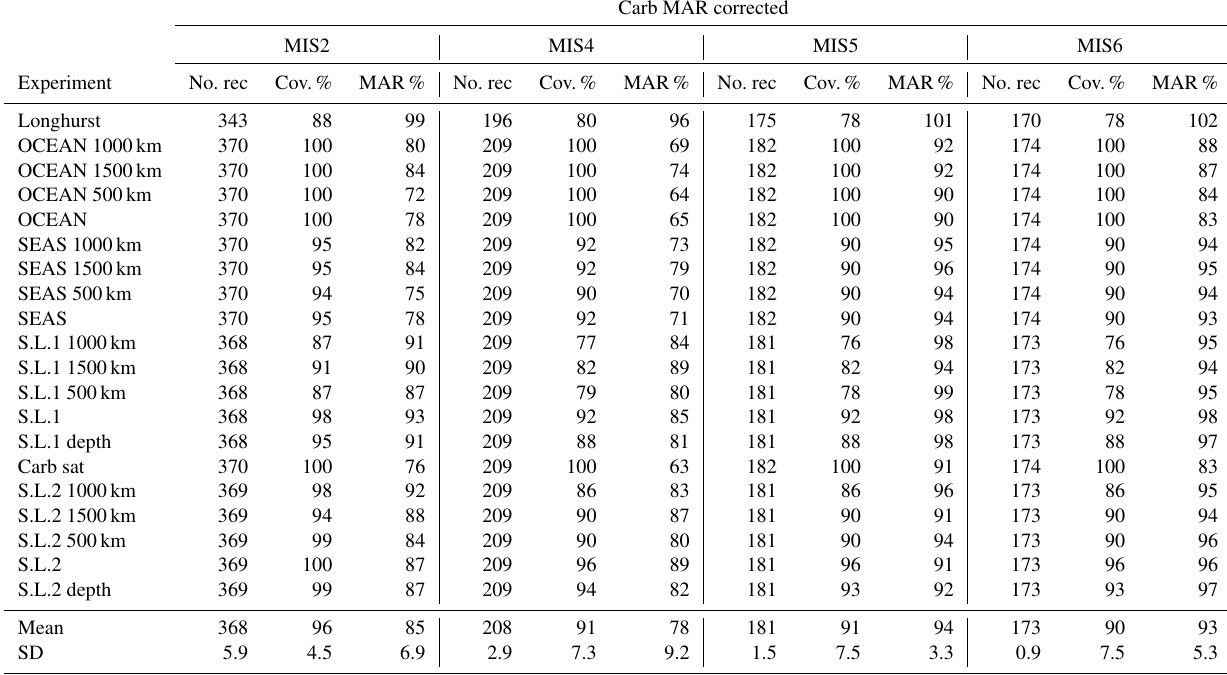
Table 2. Summary of estimated changes in carbonate MAR for each province map. The number of records used, mean coverage (%), and mean MAR (in % of modern value) are shown for four intervals (LGM, MIS4, MIS5e, and MIS6) for each province map. The results correspond to the calculations of temporal variability shown in Fig. 5f. The modern burial map used for all calculations corresponds to Fig. 2a.